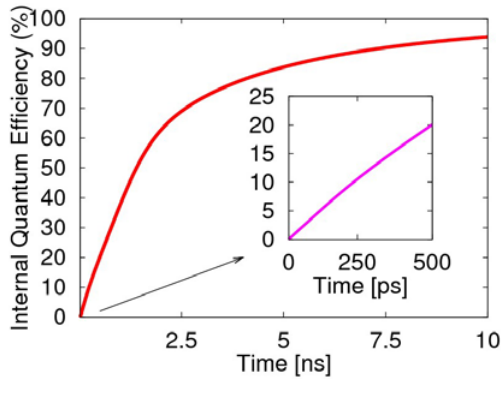
Figure 7. Evolution of the electroluminescent internal quantum efficiency, including the decay of the singlet exciton and emission from the two-transition process of the triplet